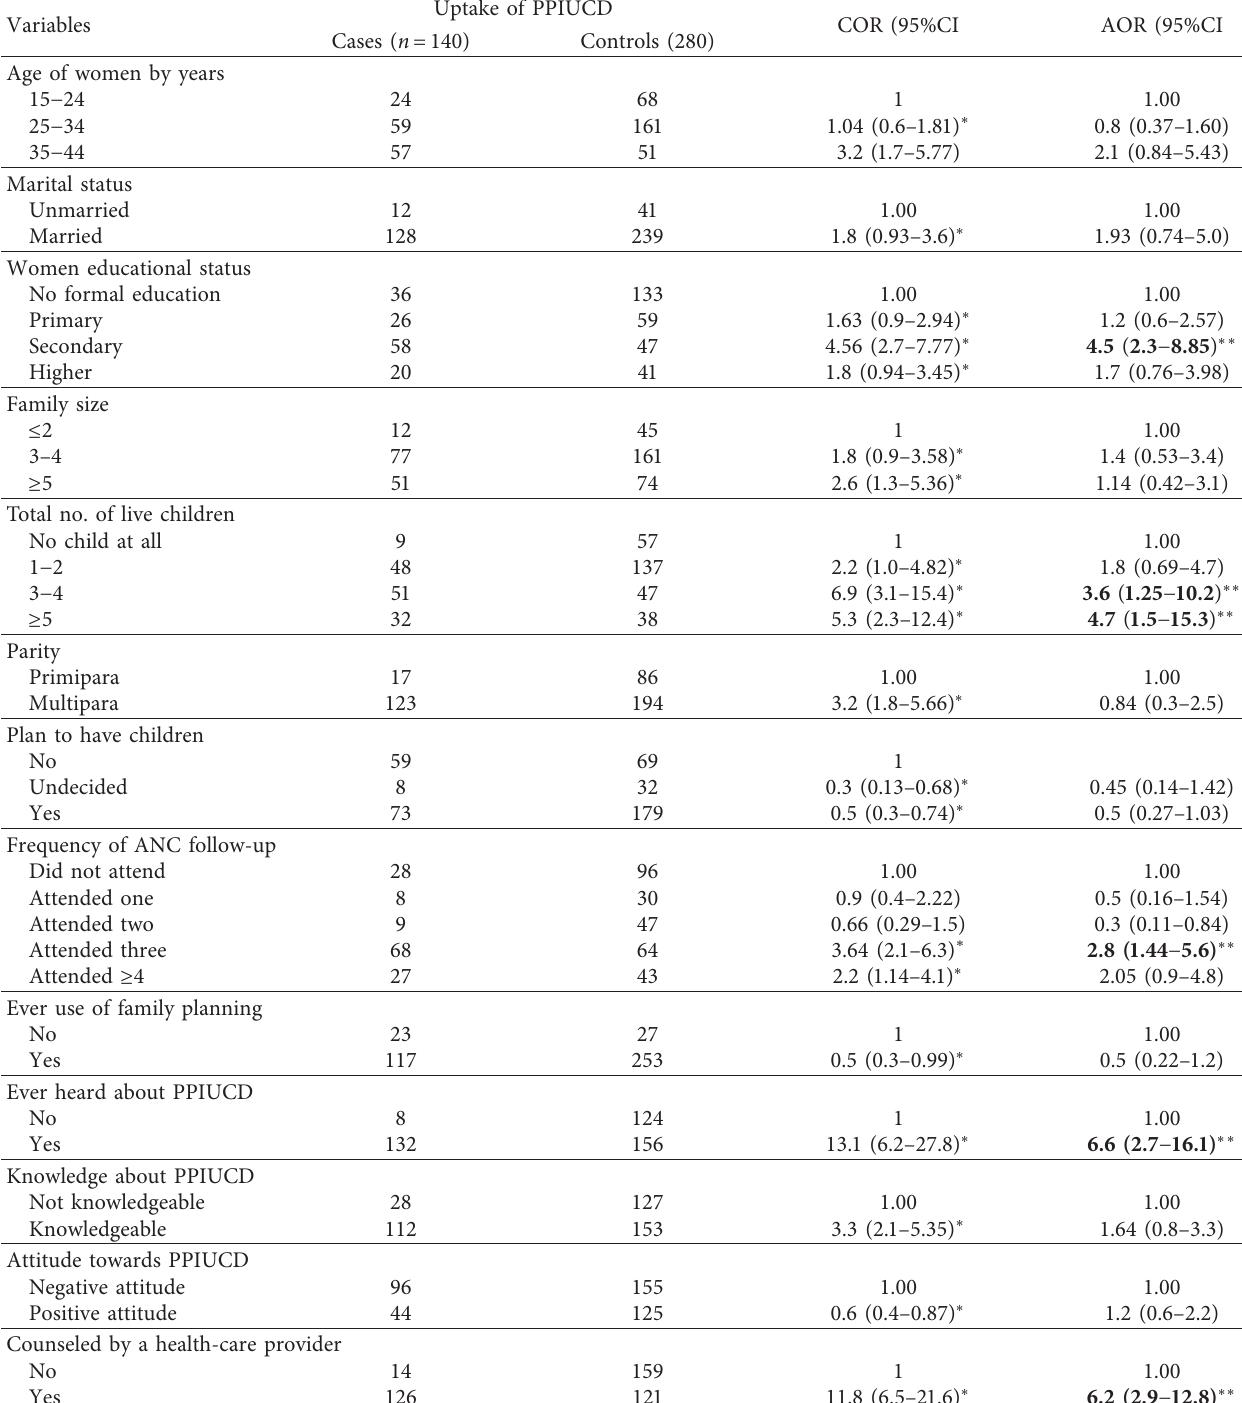
Table 6: Bivariate and multivariable logistic regression analysis of determinant factors for the uptake of PPIUCD among women delivering in public hospitals of South Gondar zone, Ethiopia, 2019 ( n � 140 cases and 280 controls).